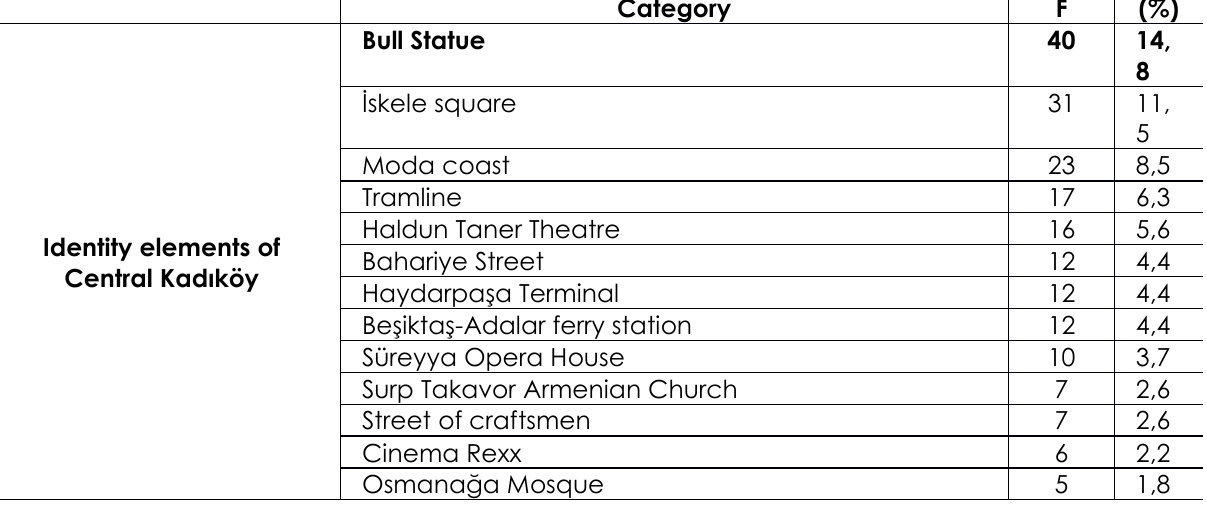
Table 2. General Assessment of